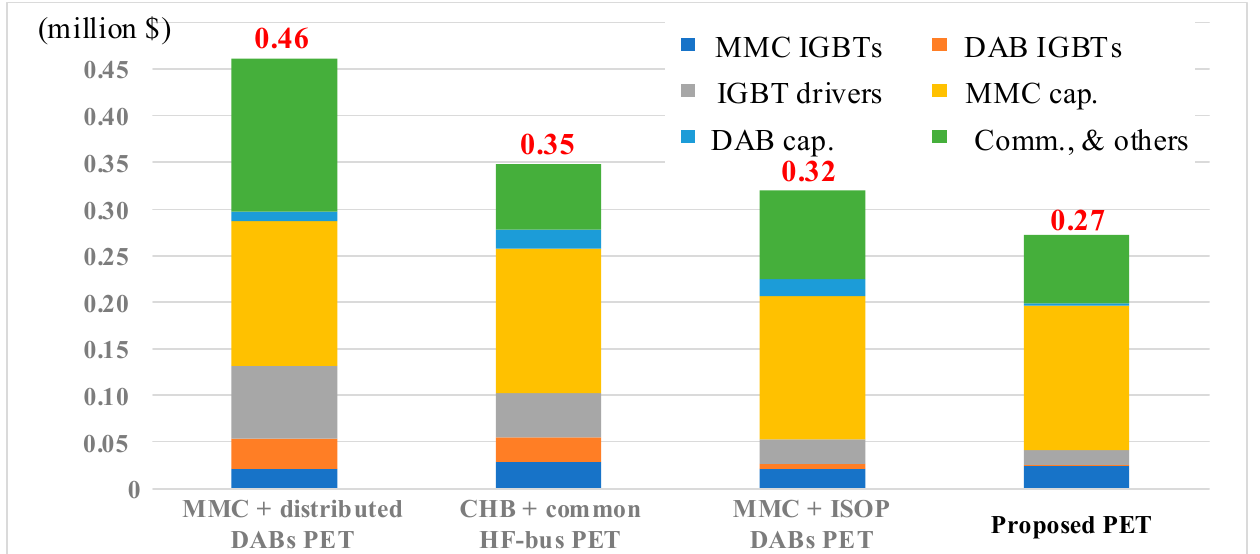
Figure 13. Devices cost comparison of proposed PET with existing typical PETs. Table 3. Device cost comparison of proposed PET with existing typical PETs. Parameters